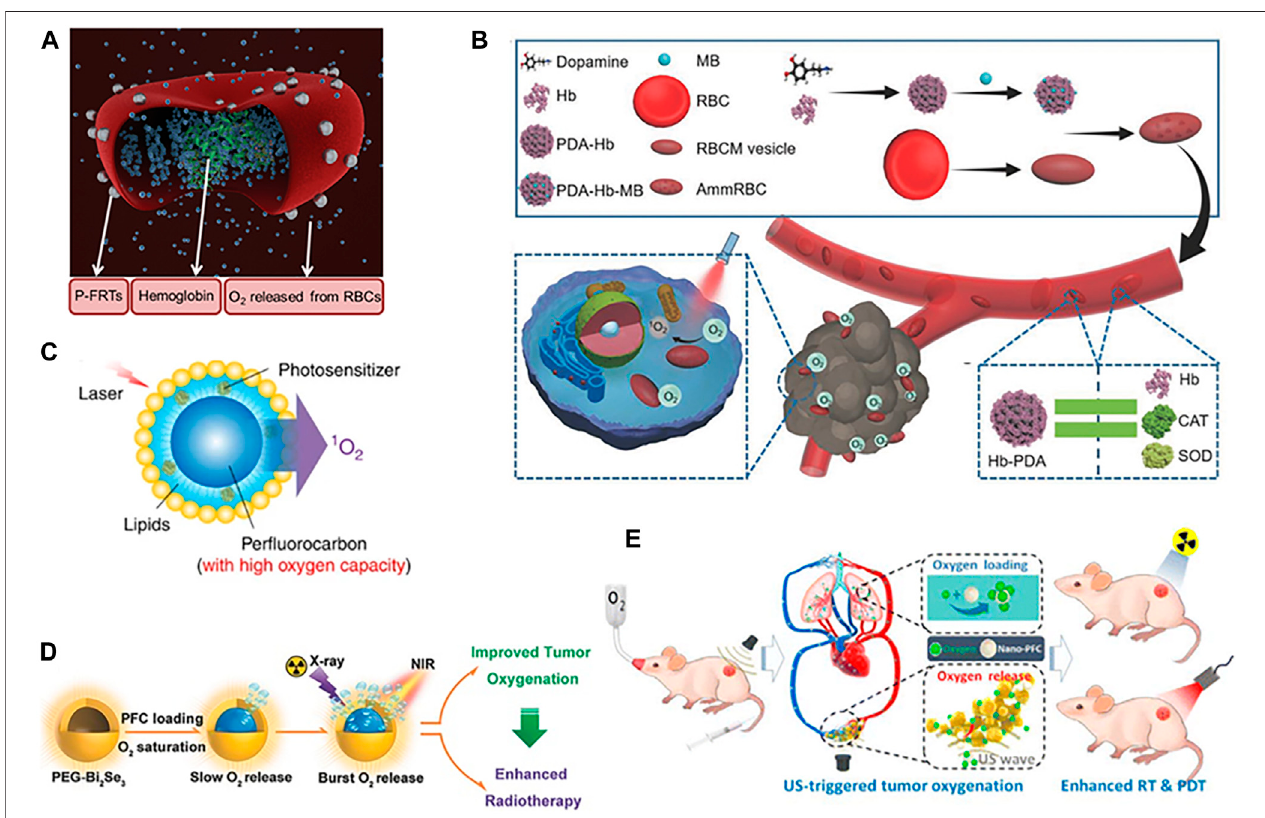
FIGURE 1 | (A) Schematic illustration of the formation and working mechanism of P-FRT-RBCs (Tang et al., 2016) (Copyright 2016, reproduced with permission from JohnWileyandSons). (B) SchematicillustrationofAmmRBCsthataccumulate inthetumor siteandboost 1 O 2 generationforenhanced PDT.Polydopamine (PDA) in AmmRBC functions like CAT and superoxide dismutase (SOD) in RBCs to protect Hb from oxidant damage during the circulation (Liu W. L. et al., 2018) (Copyright 2018, reproduced with permission from John Wiley and Sons). (C) Schematic illustration of the structure and design of the Oxy-PDT agent. Photosensitizer and per fl uorocarbon are coencapsulated by lipids. Photosensitizers are uniformly dispersed inside the lipid monolayer and PFC in the core of the nanoparticle. When irradiatedbylaser,photosensitizer(PS)transfersenergytotheoxygenenrichedinPFC,producing 1 O 2 (Chengetal.,2015)(Copyright2015,reproducedwithpermission from Nature Publishing Group). (D) Schematic illustration of hollow PEG-Bi 2 Se 3 nanoparticles with PFC loading as an oxygen carrier and the burst release of oxygen understimulation byaNIRlaser(SongG.S.,LiangC.etal.,2016) (Copyright 2016,reproduced withpermissionfromJohnWiley andSons). (E) Schematicillustrationof the mechanism of US-triggered local oxygenation in the tumor using nano-PFC as the oxygen shuttle (Song X. J. et al., 2016) (Copyright 2016, reproduced with permission from American Chemical Society).